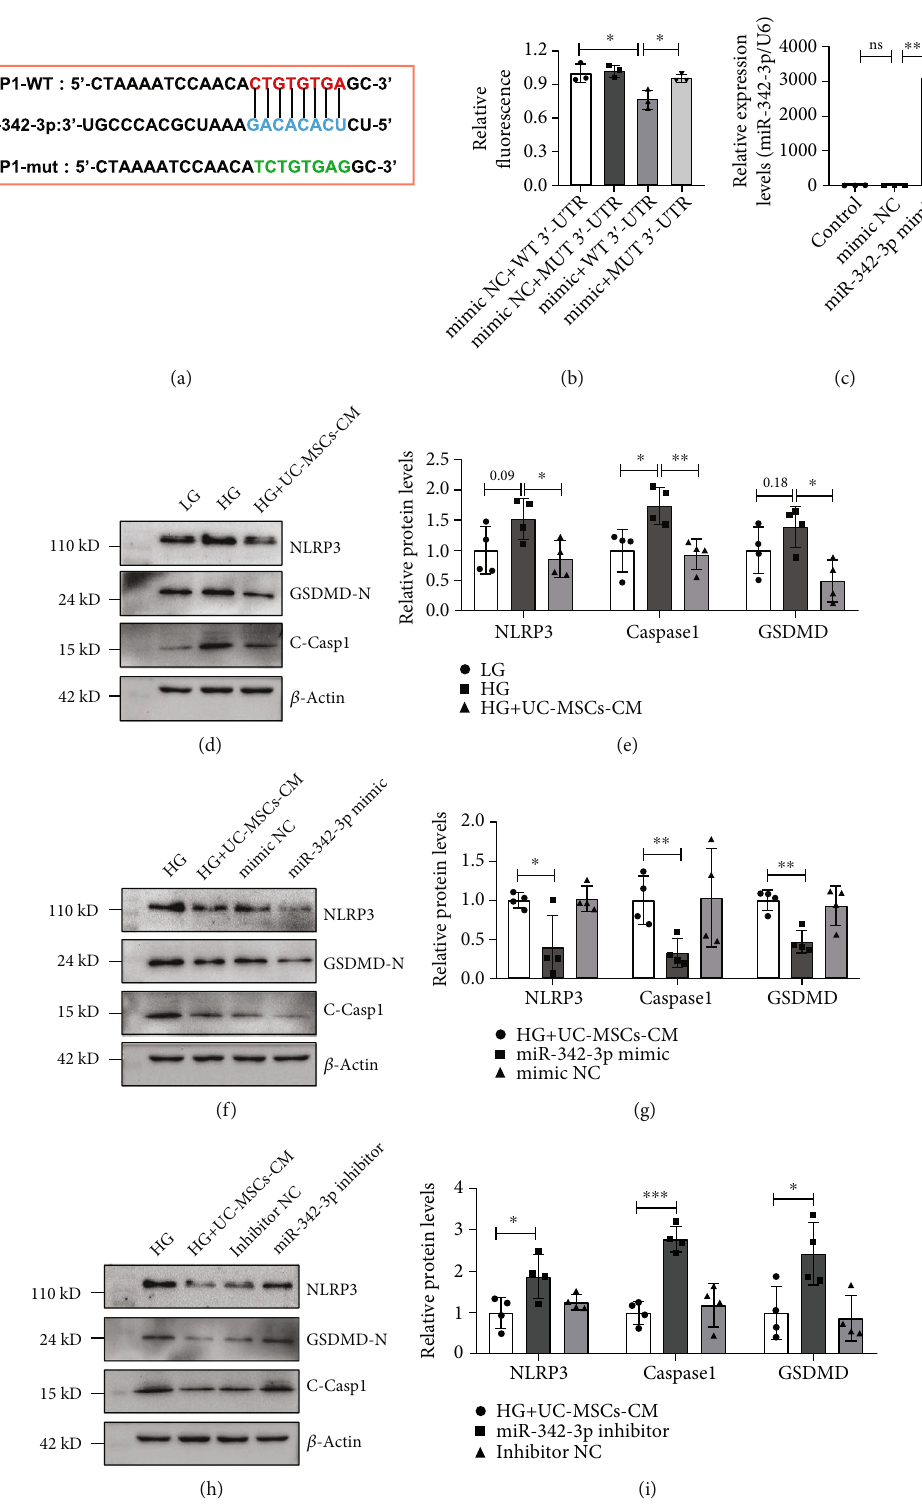
Figure 6: UC-MSC-derived miR-342-3p inhibits NLRP3 in fl ammasome activation in vitro through targeting the 3 ′ -UTR of Caspase1. (a) Putative conserved binding sites of Caspase1 with miR-342-3p and the seed sequence of miR-342-3p. (b) Luciferase activity in HEK293T transfected with constructed plasmids. (c) The expression of miR-342-3p in control, NC mimic-transfected, and miR-342-3p mimic- transfected UC-MSCs. The supernatant was collected as UC-MSC-CM. (d – i) Protein expression of NLRP3, Caspase1, and GSDMD was assayed by western blot. The data were representative of the results of three independent experiments. Data are expressed as means ± SD . ANOVA was used for comparison among multiple groups. ∗ p < 0 : 05 and ∗∗ p < 0 : 01